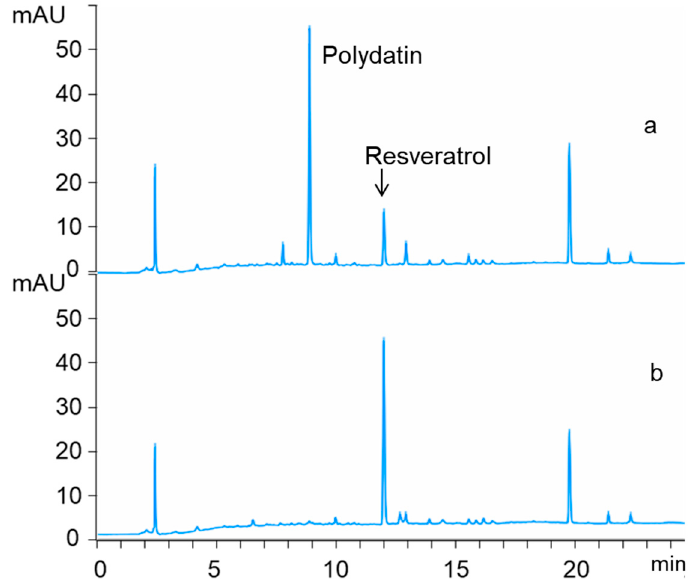
Figure 6. Representative HPLC chromatogram of 1 mg / mL R. japonica root and rhizome (RJE) before ( a ) and after ( b ) transformation by X1.